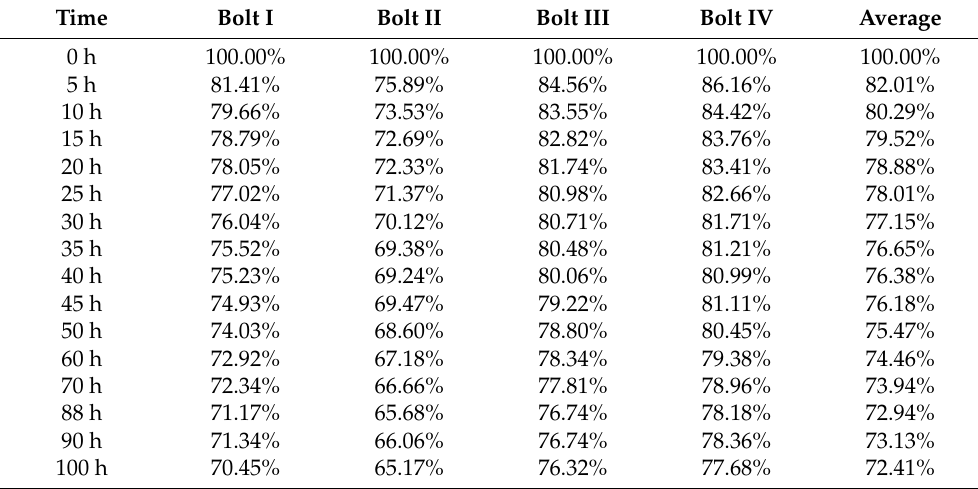
Table 5. Stress relaxation of high-strength bolts in real-time.